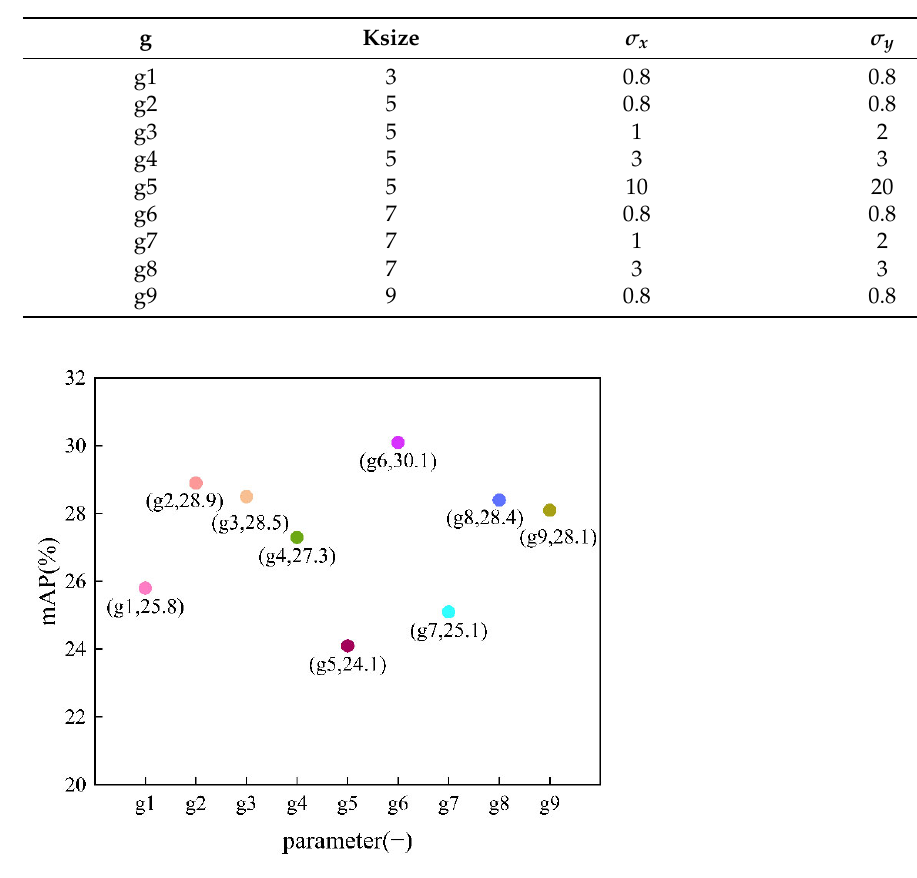
Table 1. Parameter optimization of the first algorithm.